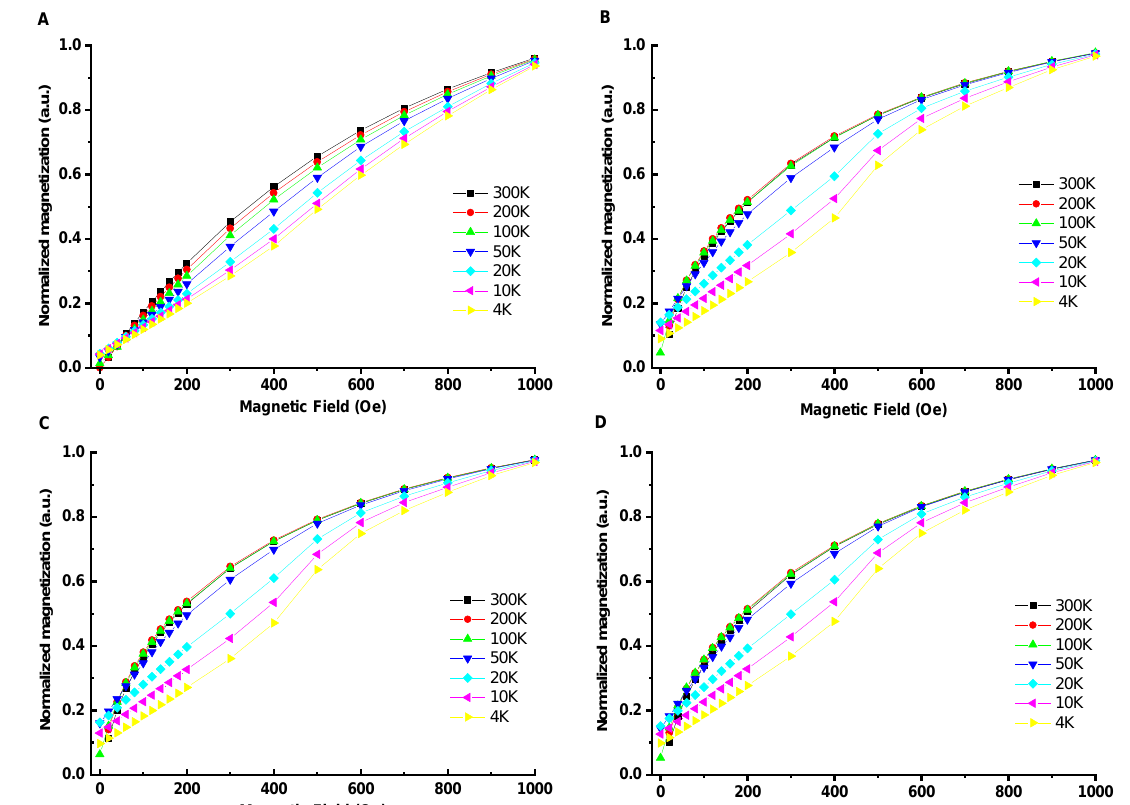
Figure 6. Normalized initial magnetization curves for the materials studied: SPIONs ( A ), ColCh 0:100 S1 ( B ), 25:75 S1 ( C ), and 50:50 S1 ( D ) taken at different temperatures.